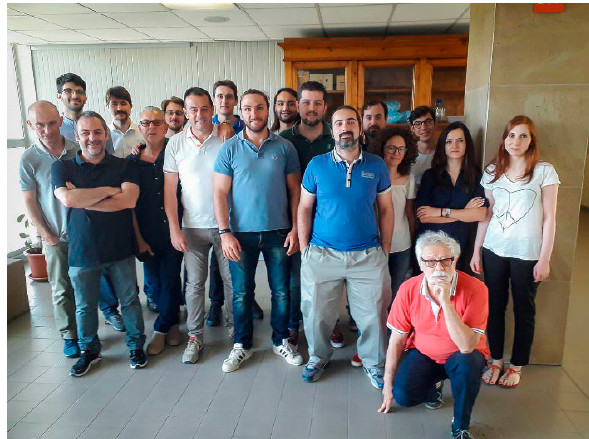
Figure 6. Applied Electrochemistry Laboratory group, headed by Professor Innocenti. Department of Chemistry of the University of